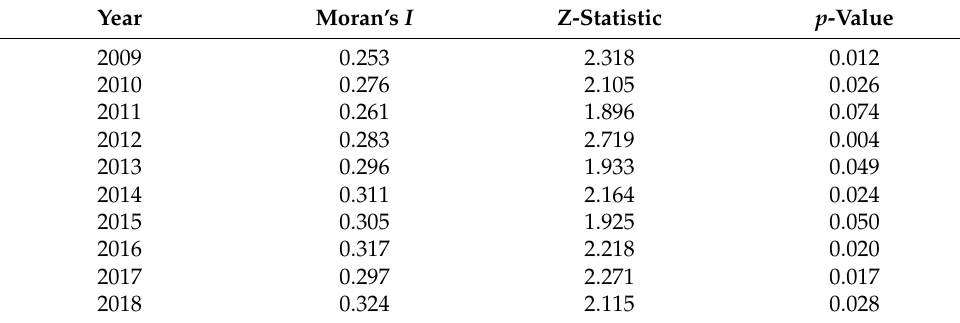
Table 3. Moran’s I of green economic growth in